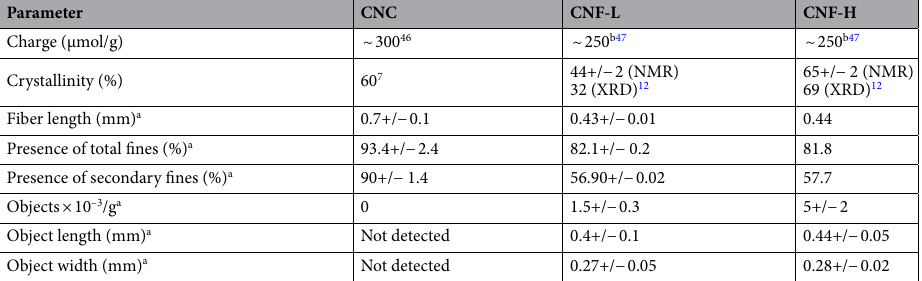
Table 2. Summary of suspension properties and films employed in this paper. CNF-L/H films were virtually indistinguishable. The error estimates are standard errors. a Measured on nanocellulose suspension using Fibertester. b Measured on the native pulp. No errors indicate that values were identical between parallels.